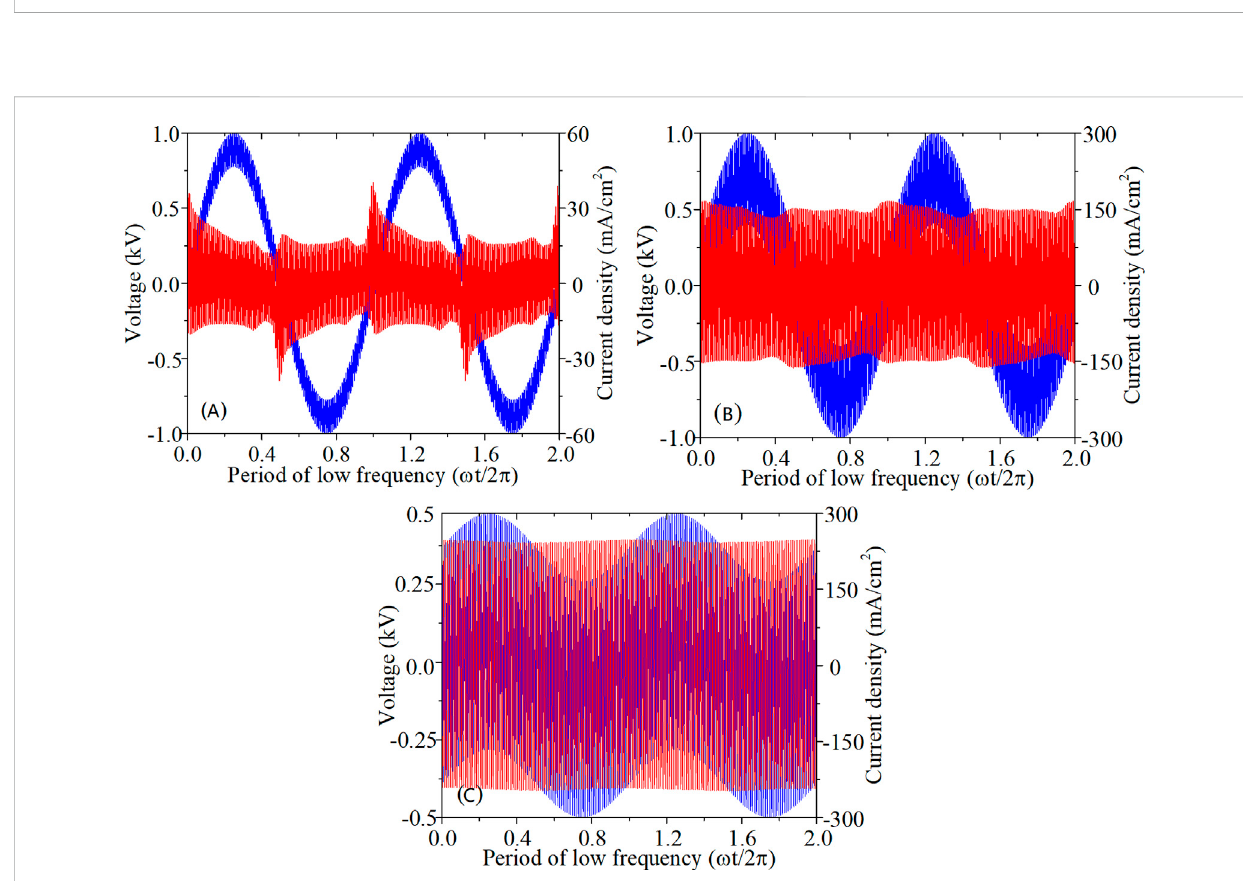
FIGURE 3 Time-dependence of the applied voltage (blue lines) and discharge current density (red lines) over two low-frequency periods with f L = 50 kHz and f H = 5 MHz; the voltage ratios of (A)